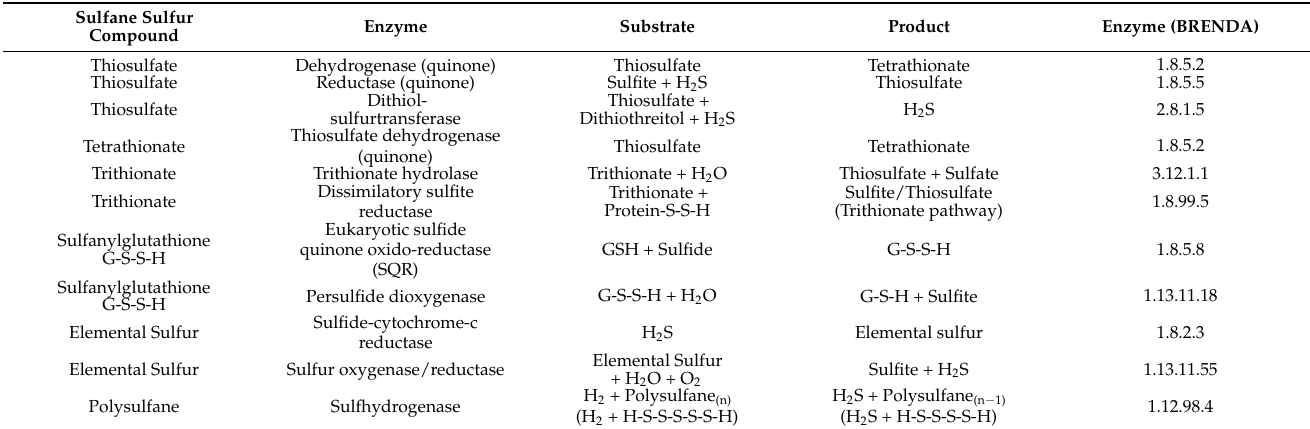
Table 4. Enzymes for sulfur metabolism involved in the transformation of sulfane sulfur compounds (selected from KEGG [89] (sulfur metabolism of Saccharomyces cerevisiae